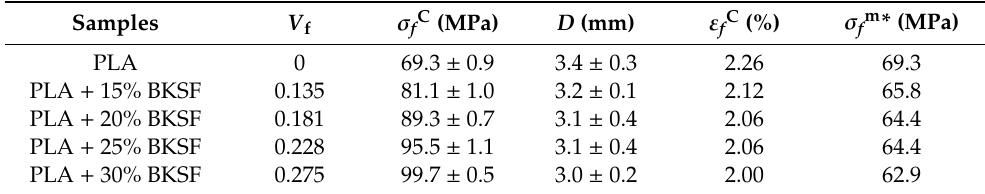
Table 1. Flexural strength ( σ f C ), deflection (D) and strain ( ε f C ) of the polylactic acid with bleached